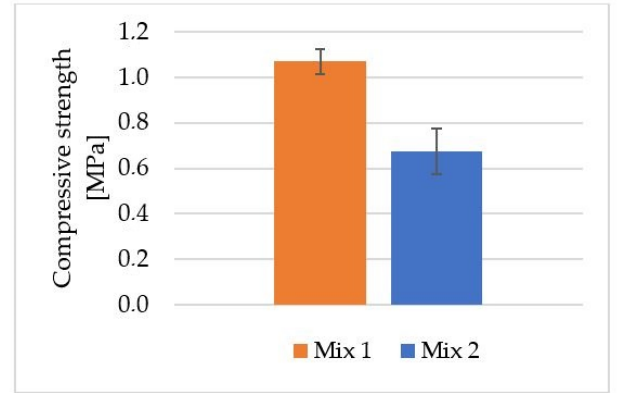
Figure 5. Average compressive strength for geopolymer material obtained via mold casting method.